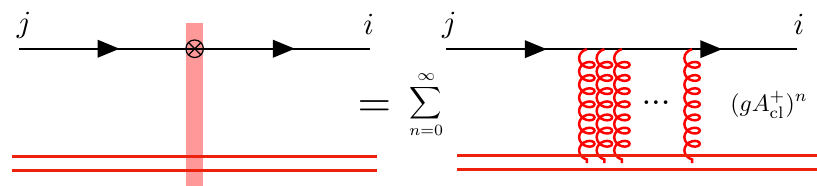
Figure 1 . The effective vertex of the dressed quark propagator on the l.h.s. of the figure represents the multiple scattering off the classical gauge fields A + The n = 0 term represents the free quark